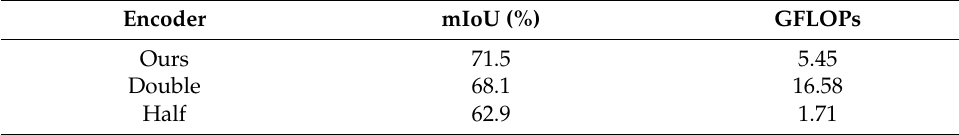
Table 5. Results of a different width of our networks on Cityscapes.